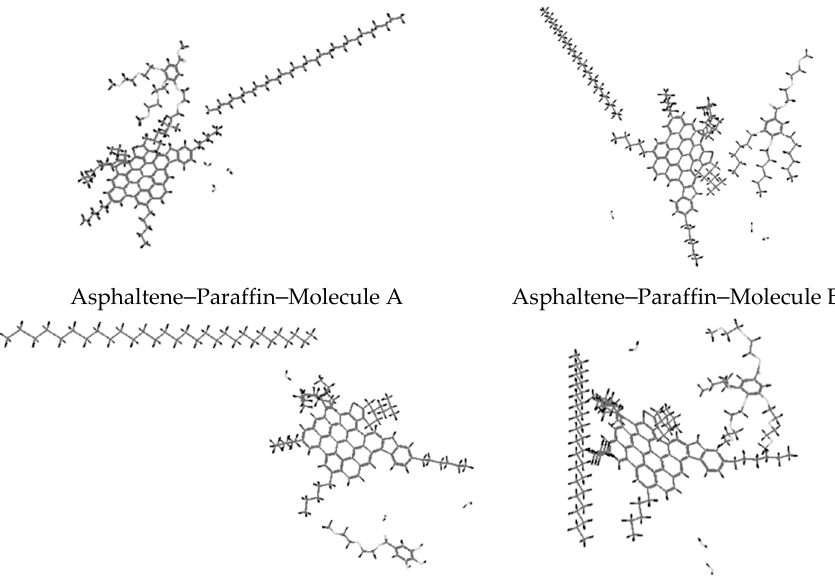
Figure 3. Interaction of conglomerates and three water molecules.